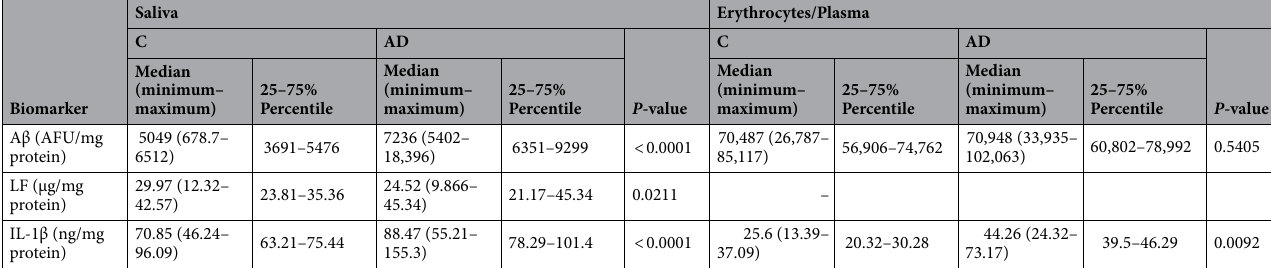
Table 3. The concentration of salivary and erythrocytes/plasma Aβ, LF, IL-1β and IL-1β in patients with Alzheimer’s disease and the control group. C—control group; AD—Alzheimer’s disease; Aβ—amyloid beta, LF—lactoferrin; IL-1β—Interleukin 1 Beta.